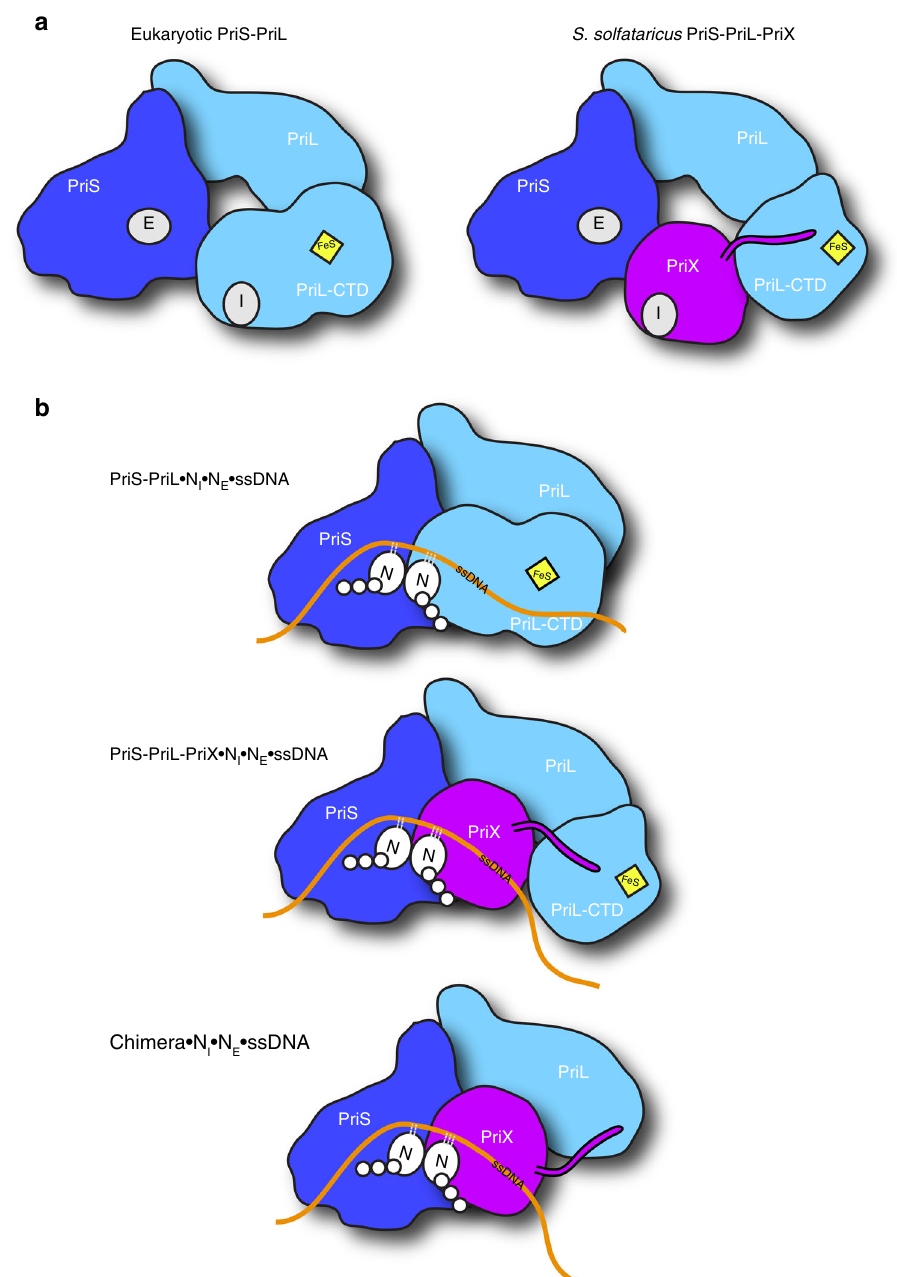
Fig. 9 Model of RNA primer synthesis by eukaryotic PriSL and archaeal PriSLX, highlighting the respective roles of PriX and PriL-CTD in primer synthesis. a Subunit structure of eukaryotic (left) and (right) S. solfataricus primases. b Primer initiation complexes for eukaryotic PriSL (top), archaeal PriSLX (middle) and Chimera Poly(dT)-templated primase assay . Ten-microlitre reactions contained 50 mM MES-NaOH pH 6.5, 10 mM MnCl 2 , 0.1 mg ml − 1 BSA, 10 μ M ZnCl 2 , 10 μ M ATP, 1 μ Ci [ α - 32 P]ATP, 100 ng poly(dT) (Amersham biosciences), 150 μ M ApA (TriLink BioTechnologies, presented in ApA extension assay), 160 nM ribo(A8) (IDT, presented in 8mer primer extension assay) and the indicated amount of primases. The reactions were incubated at 75°C for 20 min before being quenched by the addition of an equal volume of loading buffer (98% formamide, 10 mM EDTA). The mixtures were boiled for 5min and analyzed by electrophoresis through a 20% polyacrylamide, 8M Urea, 1× TBE gel and visualized by phosphorimagery on a Typhoon scanner (GE Healthcare). End-labeled primer extension assay . ApA or ribo(A8) was end labeled with [ γ - 32 P]ATP using T4 PNK (New England Biolabs) and labeled ribo(A8) primer was annealed to poly(dT) prior to the reaction. The reaction condition is essentially the